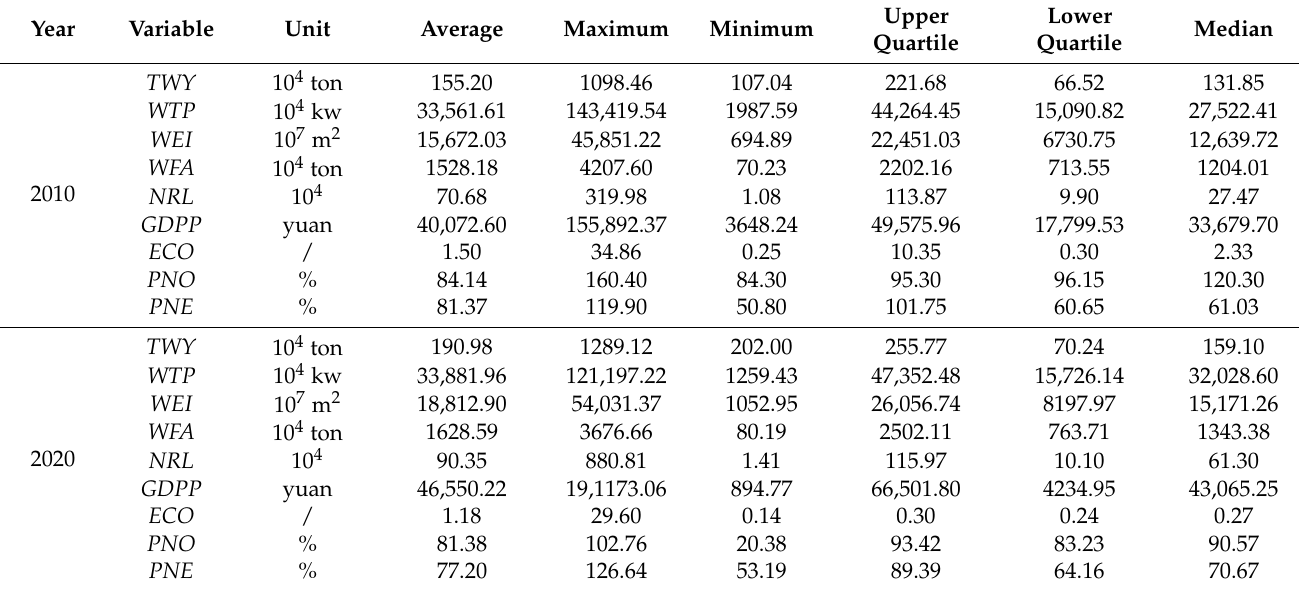
Table 1. Variable descriptive